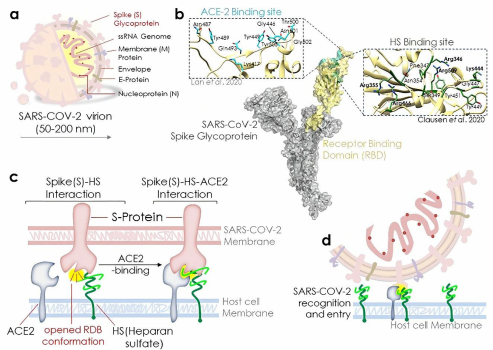
Figure 1. ( a – d ) Heparan sulfate plays an important role in the binding of the SARS-CoV-2 spike protein (S-protein) to ACE2 and related viral infections. Reprinted with permission from Ref. [34]. ©2021, Rajkumar Sigh Kalra et al., (CC BY 4.0) (for a detailed interpretation of Figure 1, the reader is referred to